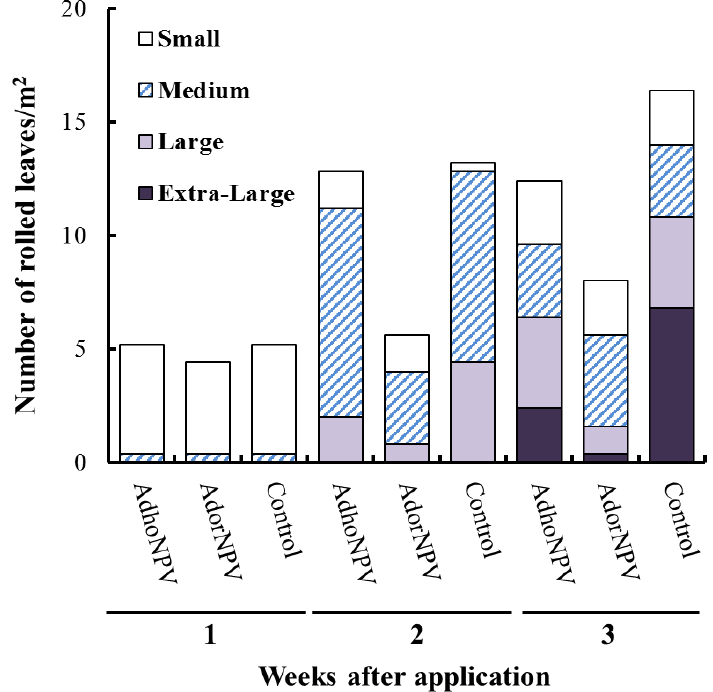
Figure 4. Number of rolled leaves produced by A. honmai larvae with damaged